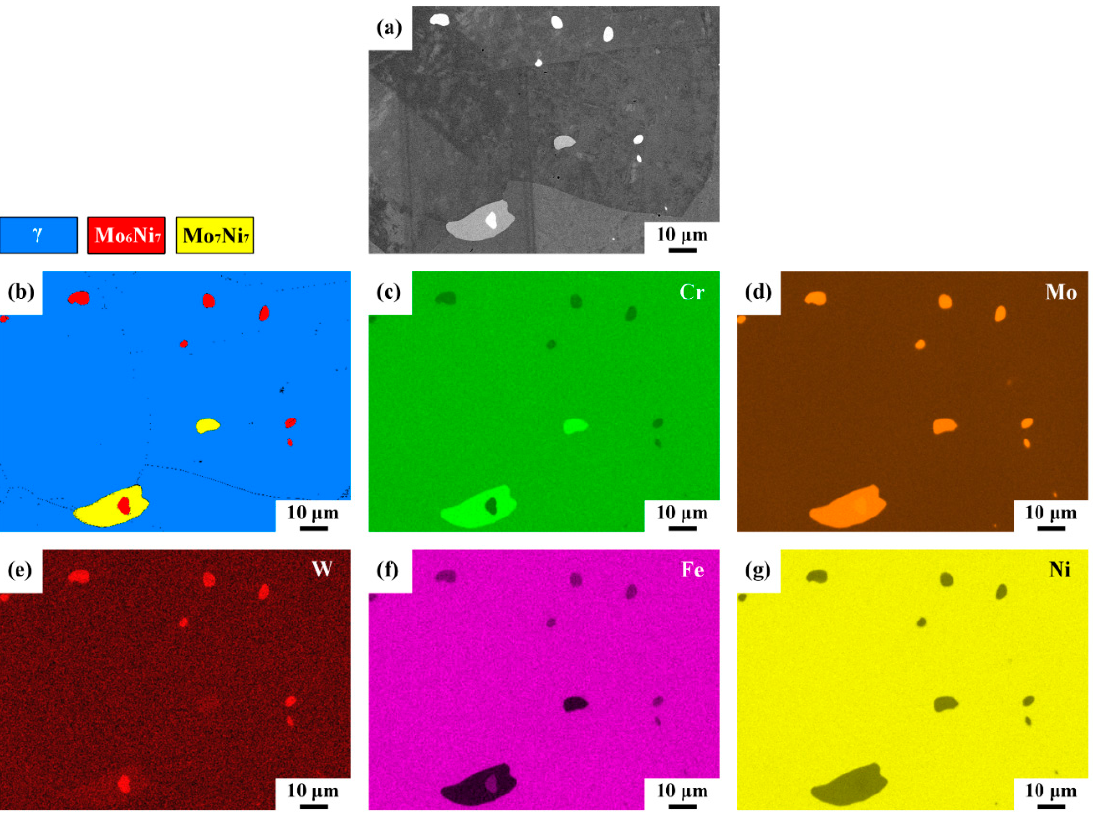
Figure 6. ( a ) SEM-BSE image and ( b ) EBSD phase map of the examined sample; ( c – g ) the composi- tional maps determined by EDS.